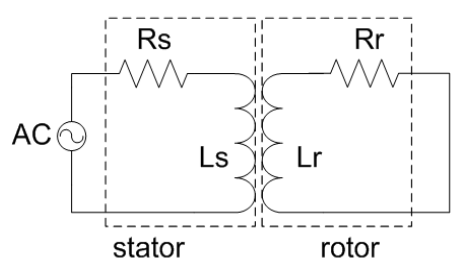
Figure 3. Schematic drawing of the sensor with short circuit at the